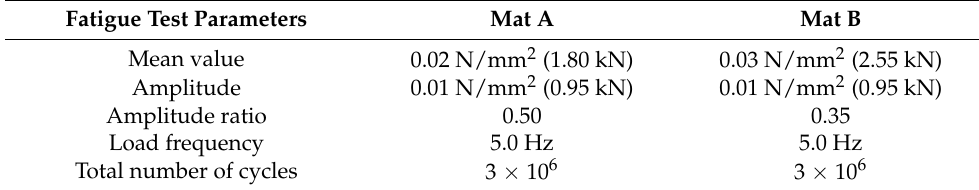
Table 2. Cyclic load (fatigue loading) characteristics for two types of